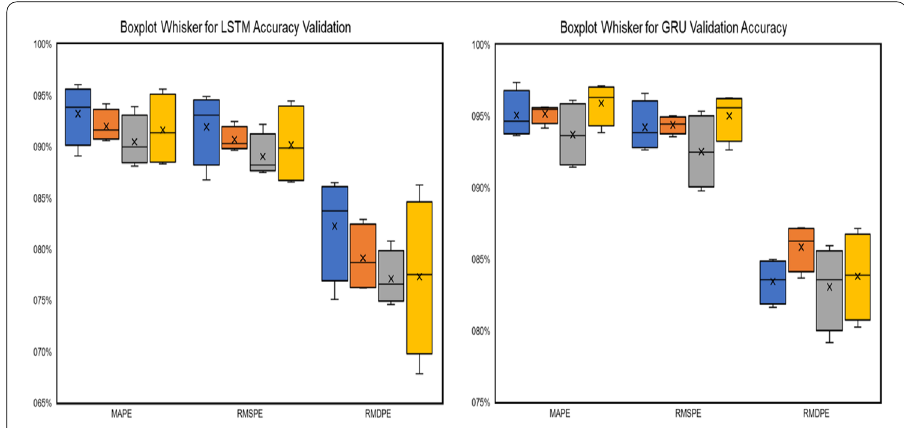
Fig. 16 Boxplot Whisker for LSTM and GRU validation